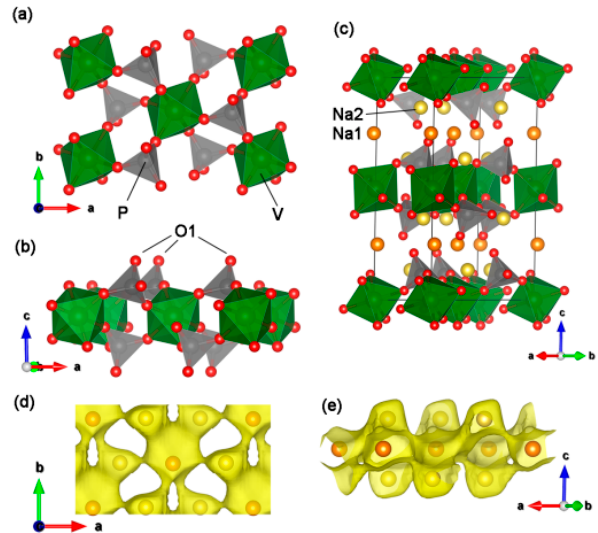
Figure 3. ( a – c ) Structural illustration and ( d , e ) BVS map of layered Na 3 V(PO 4 ) 2